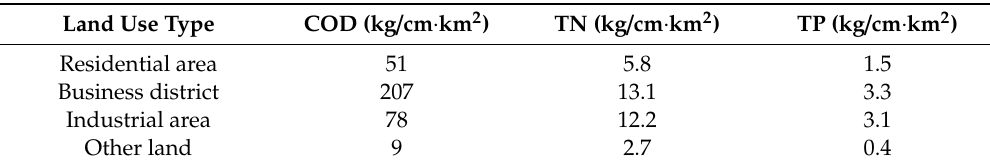
Table 5. Pollutant concentration parameters.